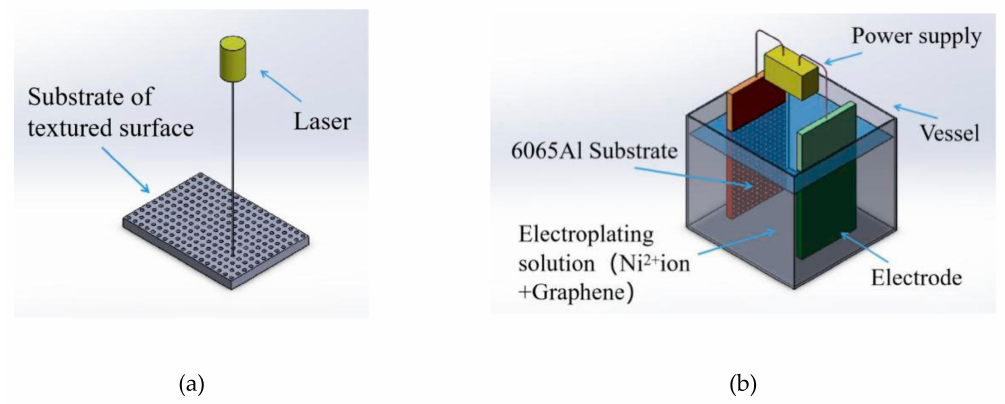
Figure 1. Surface texturing / composite electroplating (ST / CE) duplex treatment processing based on 6065Al. ( a ) Laser process. ( b ) Electrodeposition process. 6065Al: 6065 aluminum alloy